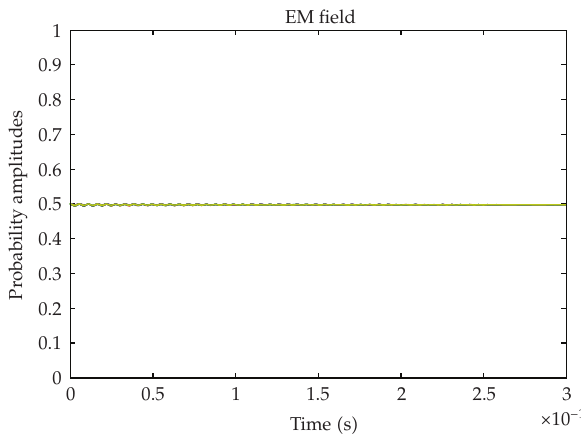
Figure 20: Right and left circular polarization prob. amplitudes for large Δ